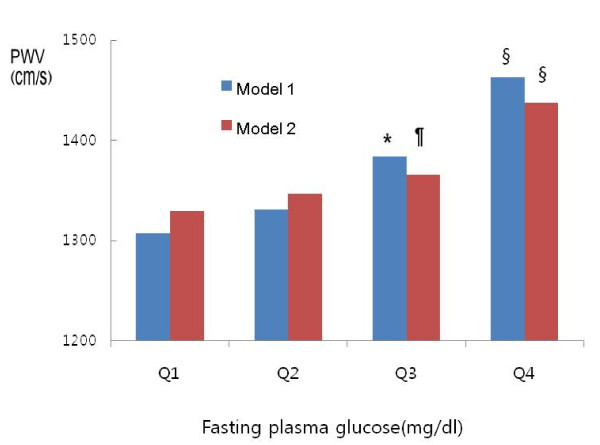
Mean values of brachial-ankle pulse wave velocity according to fasting plasma glucose quartile in non-diabetic healthy subjects. *P<0.05 vs. Q1 and Q2, § P<0.05 vs. Q1, Q2, and Q3, ¶ P<0.05 vs. Q1 Model 1; adjusted for age, sex. Model 2; adjusted for age, sex, systolic blood pressure, diastolic blood pressure, BMI, resting heart rate, Hs-CRP, HDL-cholesterol, and non HDL-cholesterol.